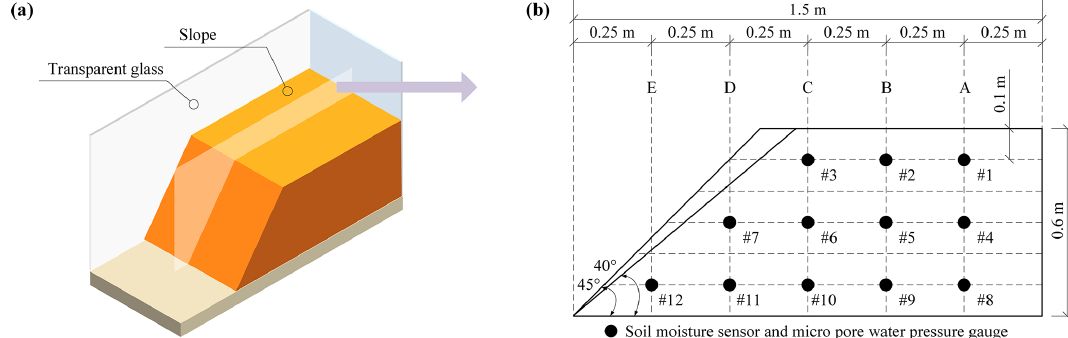
Figure 4. Flume model. (a) Three-dimensional schematic of the model. (b) Center section of the slope and sensor